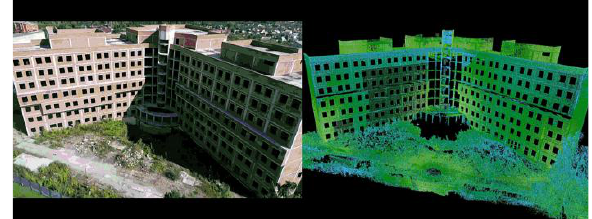
Figure 19 . Imagery and point cloud of the studied building. For each room of the building were measured the deviations of walls (Fig. 20), floors (Fig. 21), and ceilings (Fig. 22) from a plane. These deviations were presented in a convenient form that allows easily finding places with unallowable discrepancies marked in different colors. In addition to planarity deviations, the horizontal cross-sections with step 1 m were drawn (Fig. 23).